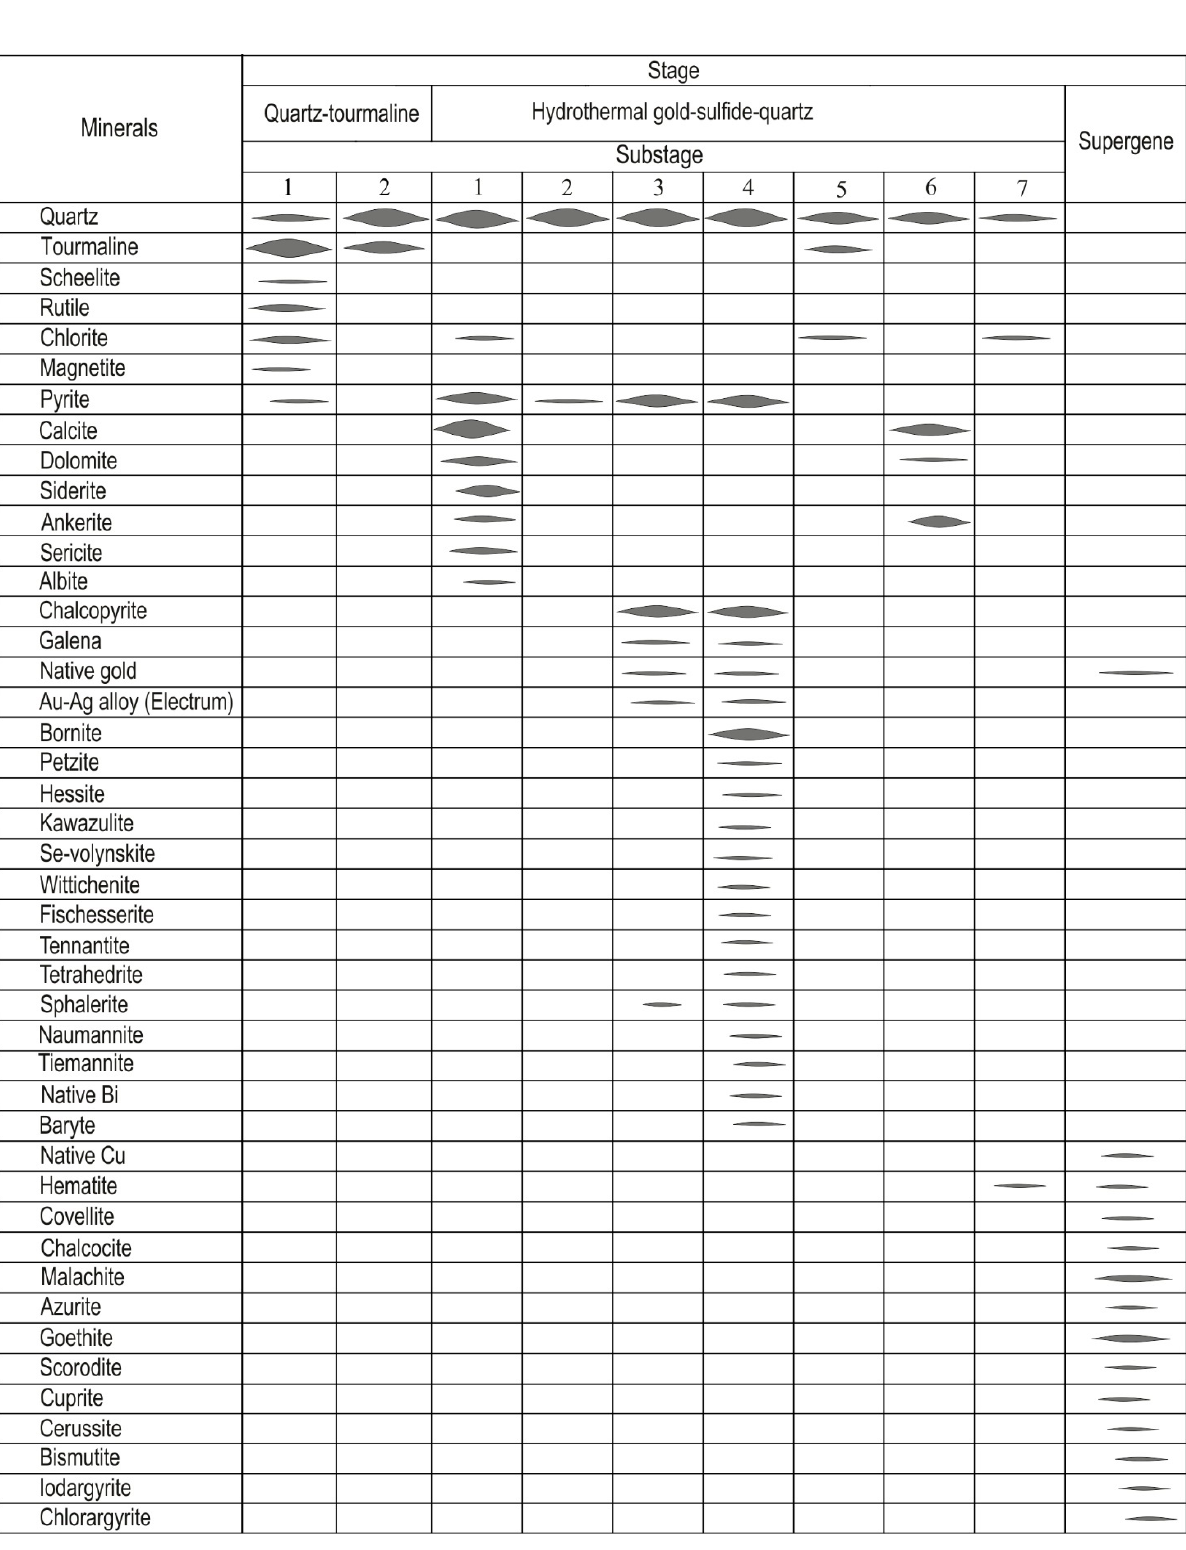
Figure 3. The para-genetic sequence of mineral formation at the Ulug-Sair ore occurrence. Quartz–tourmaline rocks (5–7 m thick, and up to 10 m long) and veins (up to 3 mm thick) are widespread throughout the occurrence (Figure 4a,b). They are altered rocks